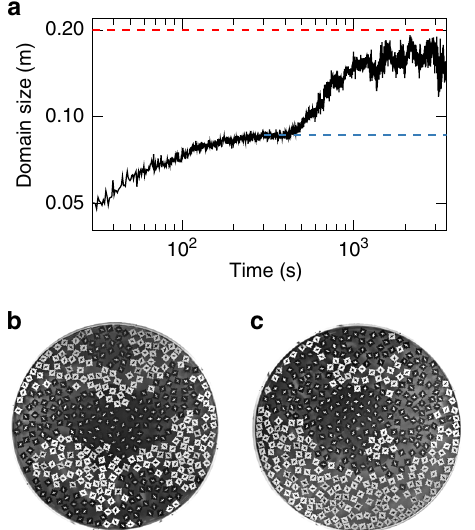
Fig. 7 Evolution of the steady state on the large plate. a Long-time evolution of demixing in the large system reaches a pleateau but is sensitive to currents at the boundary. b Metastable intermediate state after 300 s (blue dashed line in a ). c The steady state after 2000 s deviates from the fully symmetric segregation (red dashed line in a ) due to gravitational drift from shape. The particle consists of two central cylinders (c1 and c2 with mass m c1, c2 and radius r c1,c2 ), four cubes (satellites, s with mass m s , edge length a s and distance d s ) on the outside and seven cylinders (legs l with mass m l , radius r l , length l l , distance from the center d l and inclination angle θ with respect to the vertical). The total moment of inertia is the sum of individual moments considering off- central rotation for the satellites and the legs,